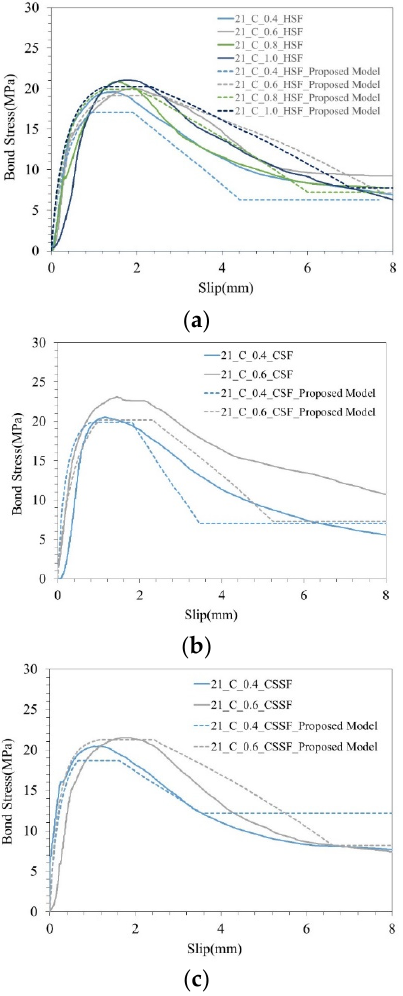
Figure 16. Proposed model for steel rebars coated with UHPC and ( a ) HSF, ( b ) CSF, or ( c ) CSSF.